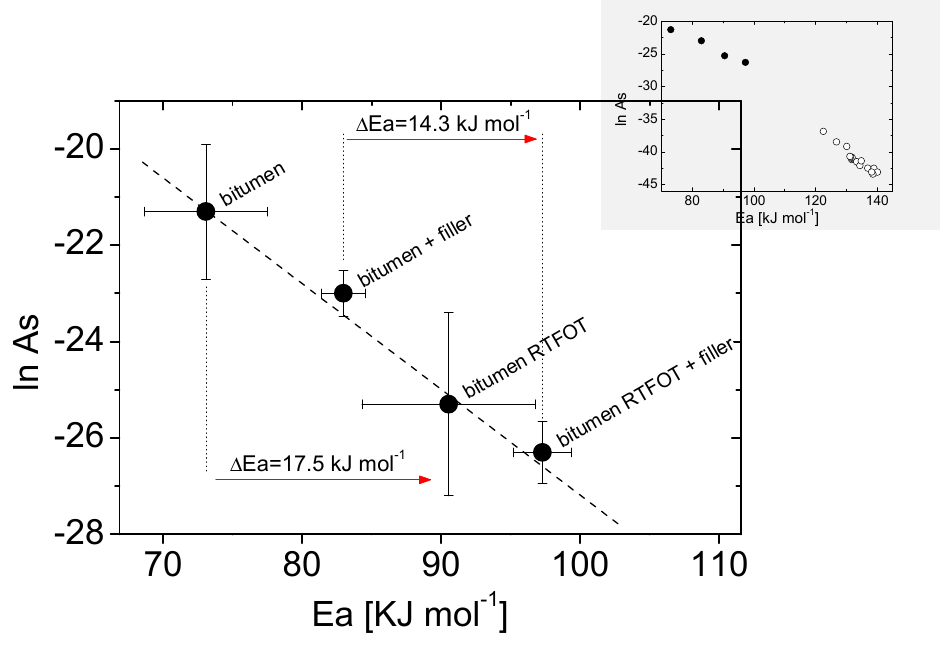
Figure 3. Correlation between the pre-exponential factor (ln As) and the activation energy (Ea). The dashed line is the linear regression of the experimental data (R = 0.986). In the inset, the data of the present paper (closed symbols) are shown together with those taken from literature (open symbols).